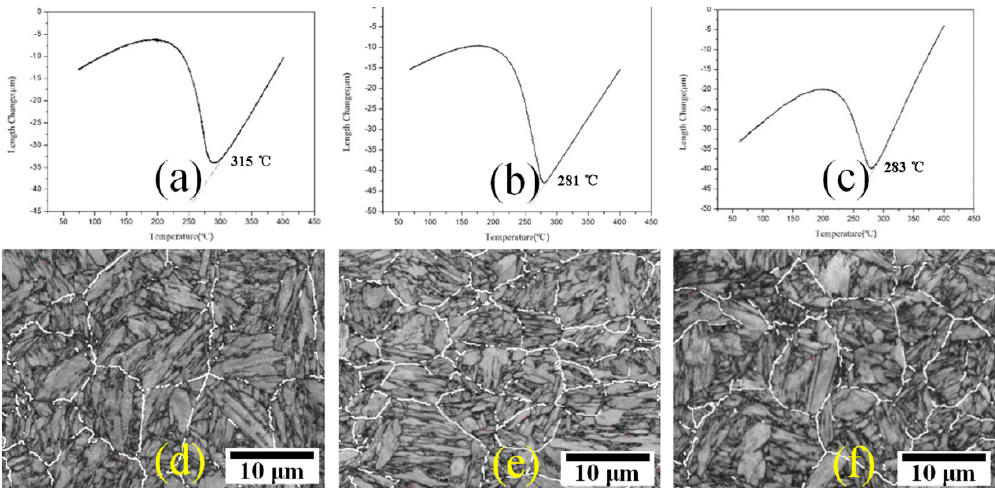
Figure 9. Dilatometric curves and EBSD band–contrast maps of different microstructures after cold rolling ( a , d ) FPM, ( b , e ) FMM and ( c , f ) TMM samples.